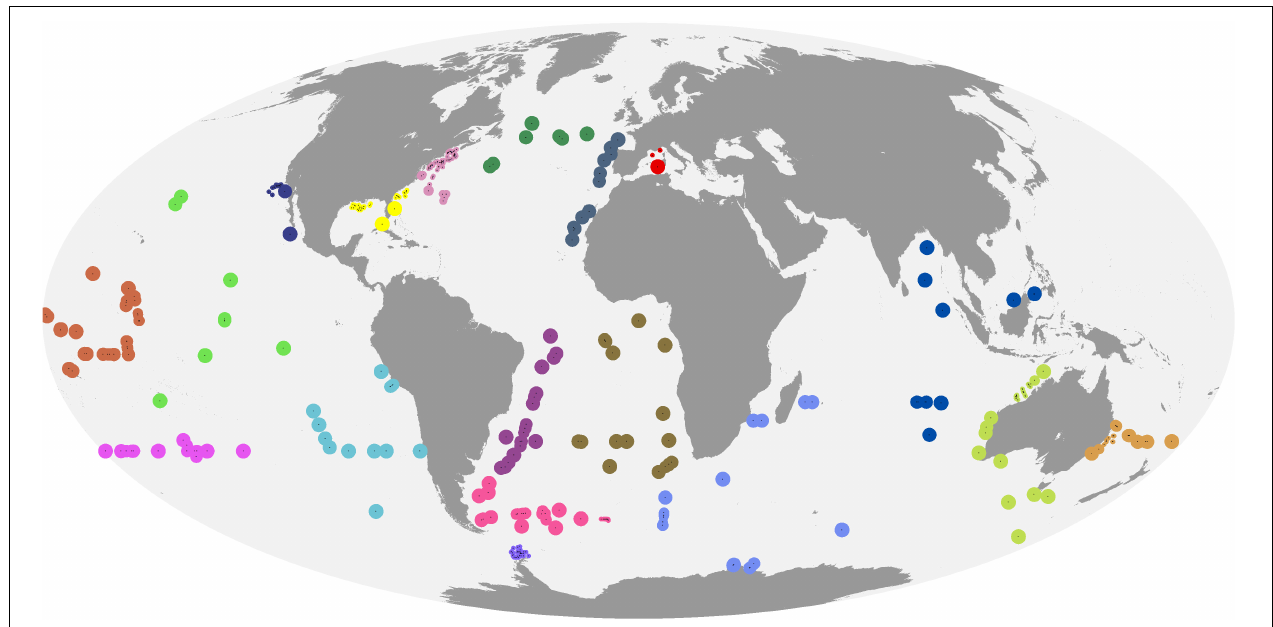
FIGURE 2 | Matched in situ and satellite observations. Colors indicate cross-validation blocks, and the areas of the circles are proportional to spatial weights.